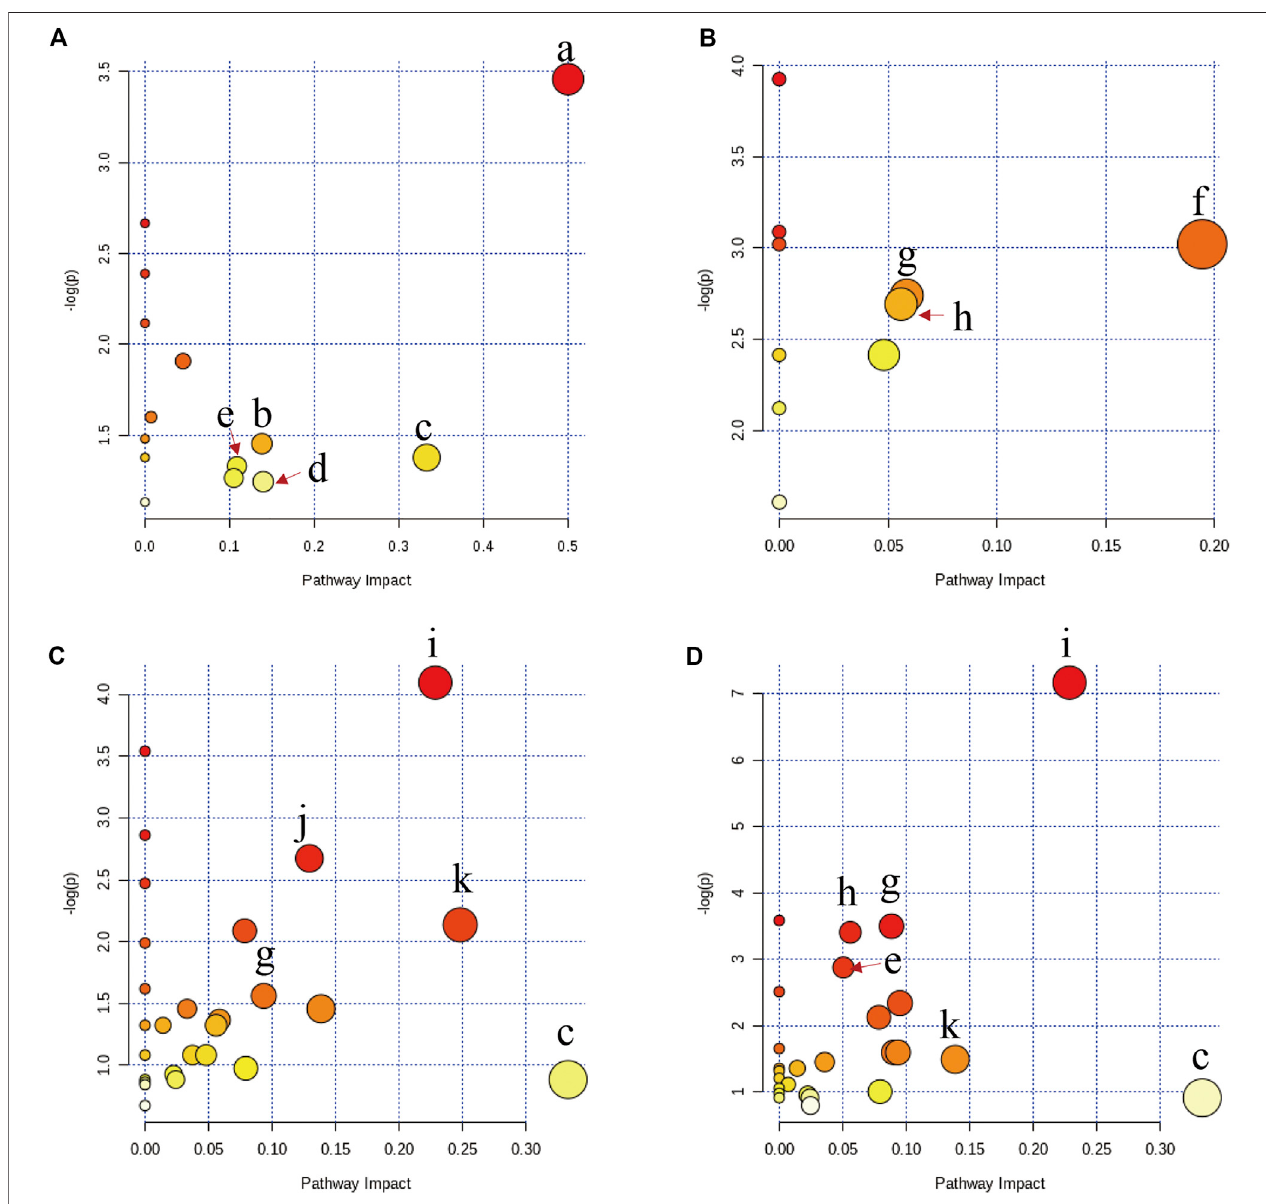
FIGURE6| Alteredmetabolicpathwaysinratswithacutebloodstasis (A) andthein fl uenceofdisturbedmetabolicpathwaysbyPNStreatment (B) ,ASAtreatment (C), andthetreatmentoftheircombineduse (D) bybubbleplot.Thecharactersofatokrepresentthephenylalanine,tyrosine,andtryptophanbiosynthesis,cysteineand methionine metabolism, arachidonic acid metabolism, tyrosine metabolism, arginine and proline metabolism, nicotinate and nicotinamide metabolism, TCA cycle, β -alanine metabolism, arginine biosynthesis, and inositol phosphate, starch, and sucrose metabolism, respectively.